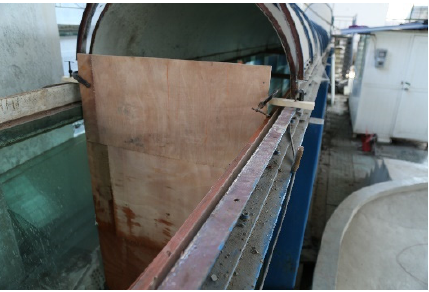
Figure 9. Wooden rigid vertical baffle (inducing fully standing waves) installed in flume.